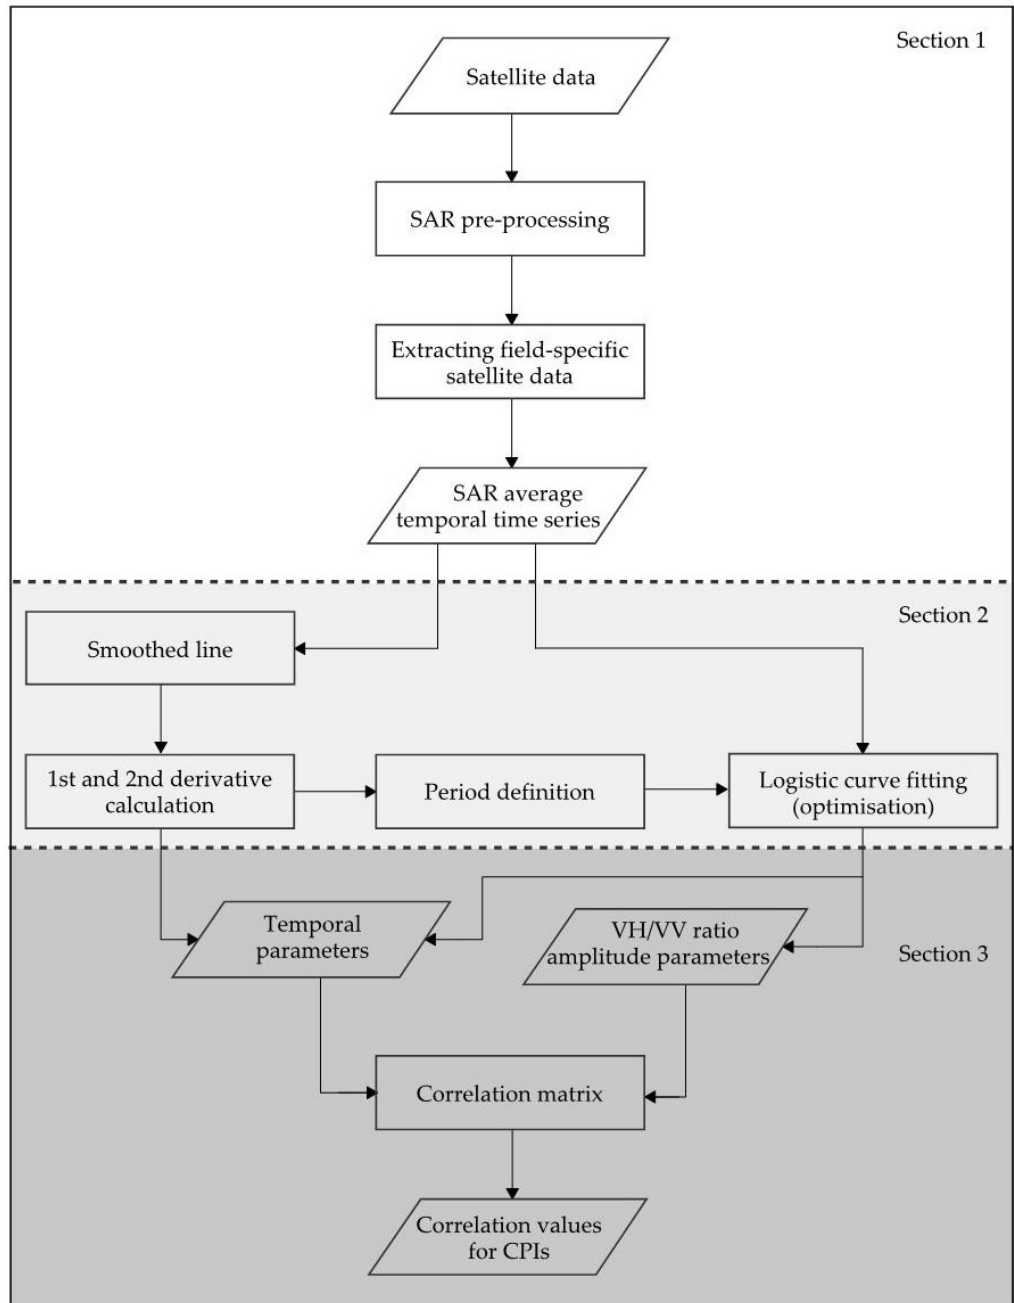
Figure 3. Flow diagram explaining the steps for the temporal analysis of synthetic aperture radar (SAR) time series, including the data and